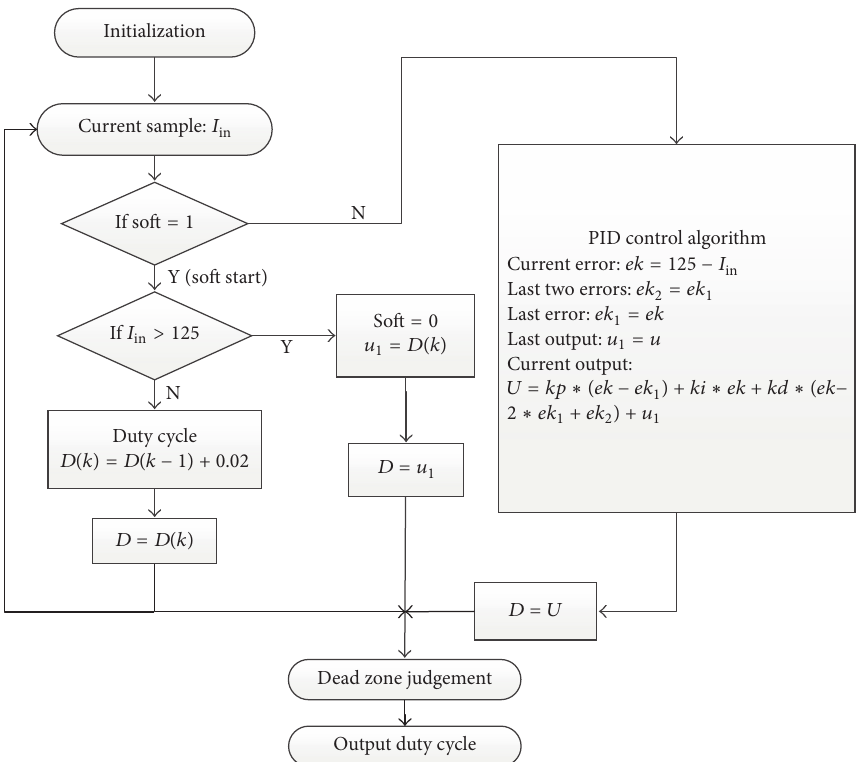
Figure 7: Soft start algorithm